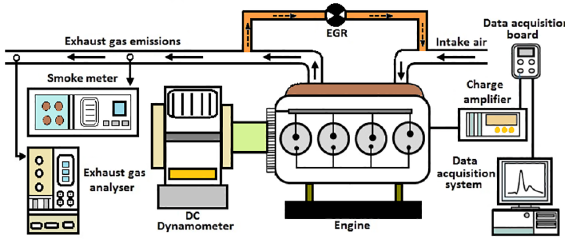
Figure 1. Schematic layout showing engine operation and experimental